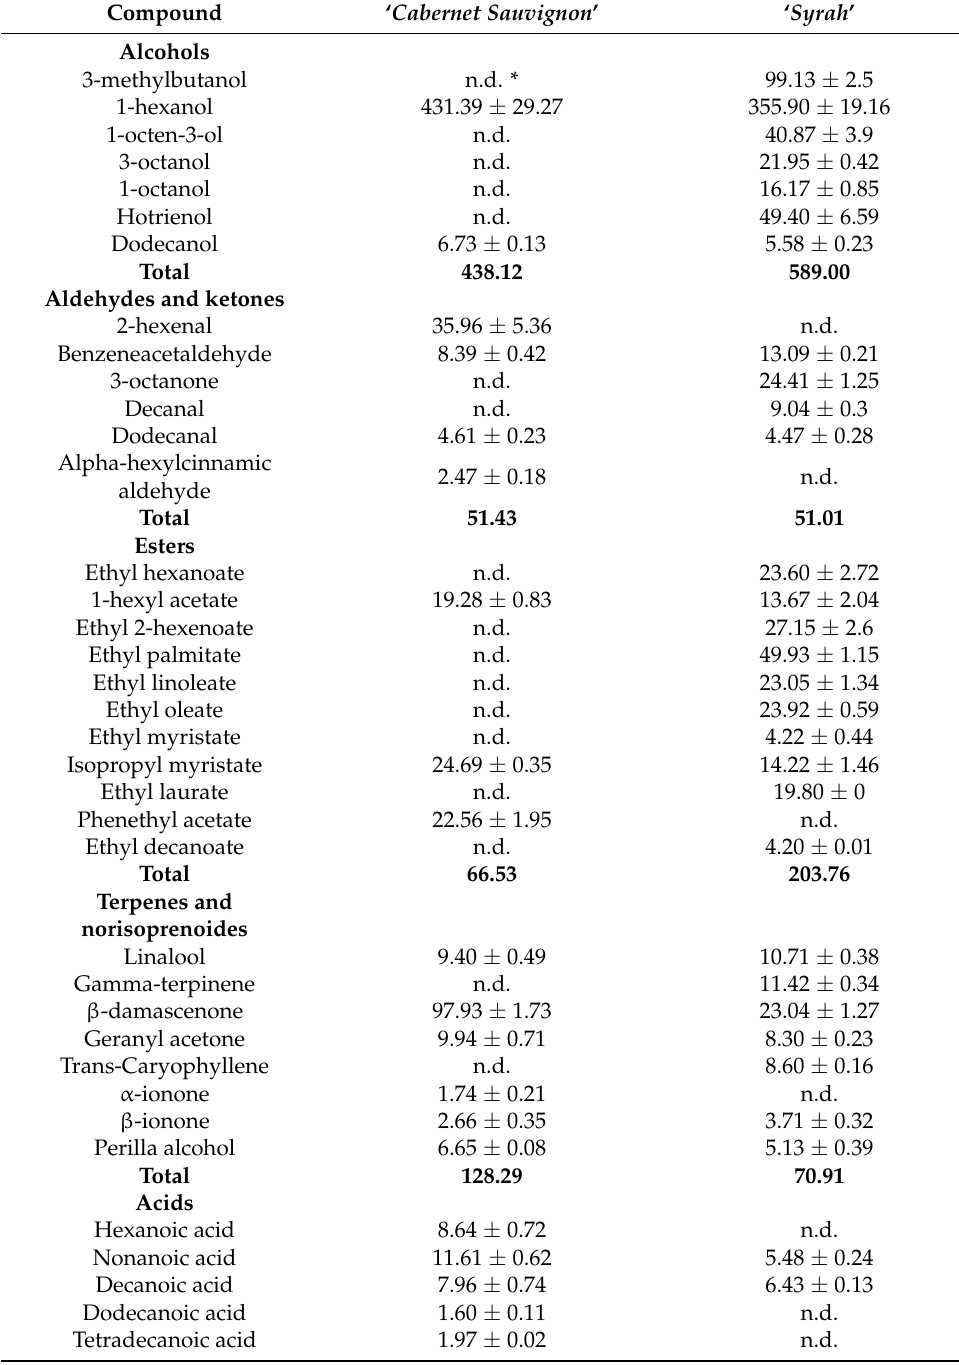
Table 4. Volatile compounds ( µ g/L) identified in ‘ Cabernet Sauvignon ’ and ‘ Syrah ’